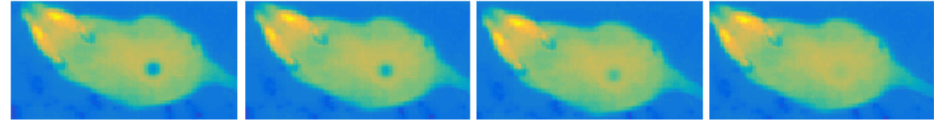
Figure 5. An original observed image with simulated circular trace of the biggest size (4 px) and different temperatures from 297 K (on the left) to 303 K (on the right).